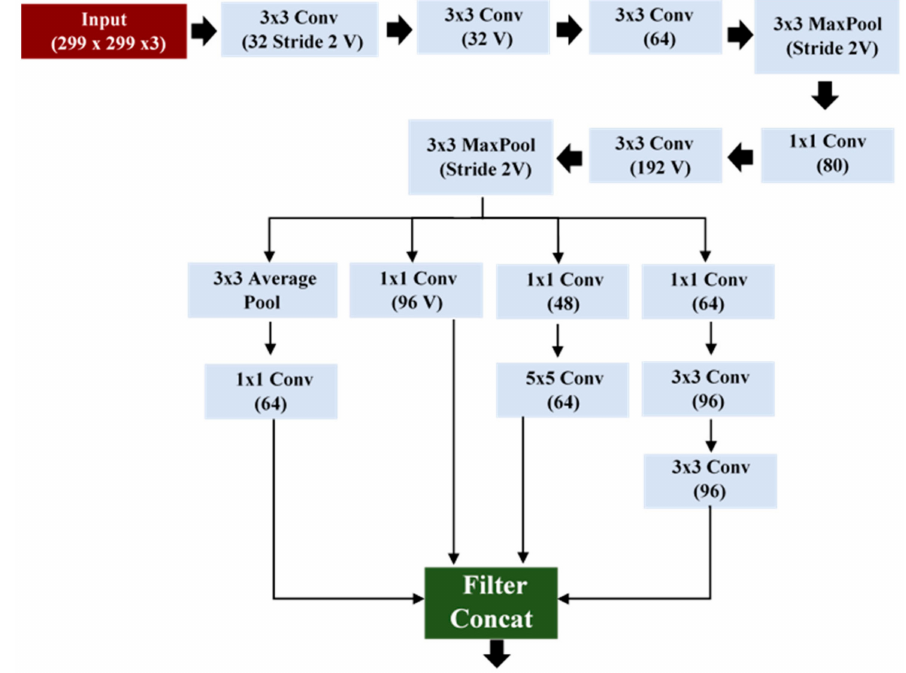
Figure 4. Stem block used in the proposed model.